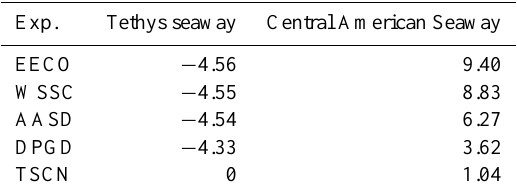
Table 2. Water mass (Sv) transport through the Tethys Seaway and the Central American Seaway. Positive values are to the east.